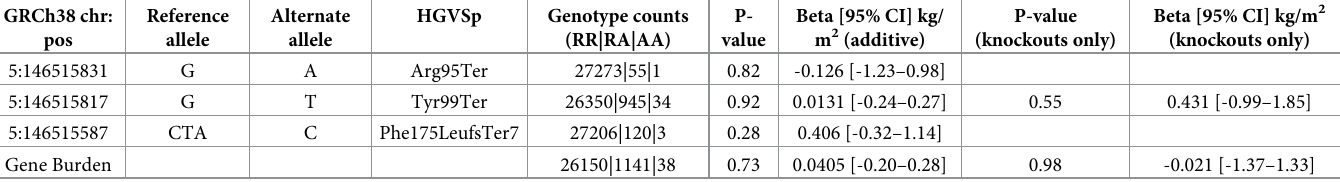
Table 1. GPR151 associations with BMI.